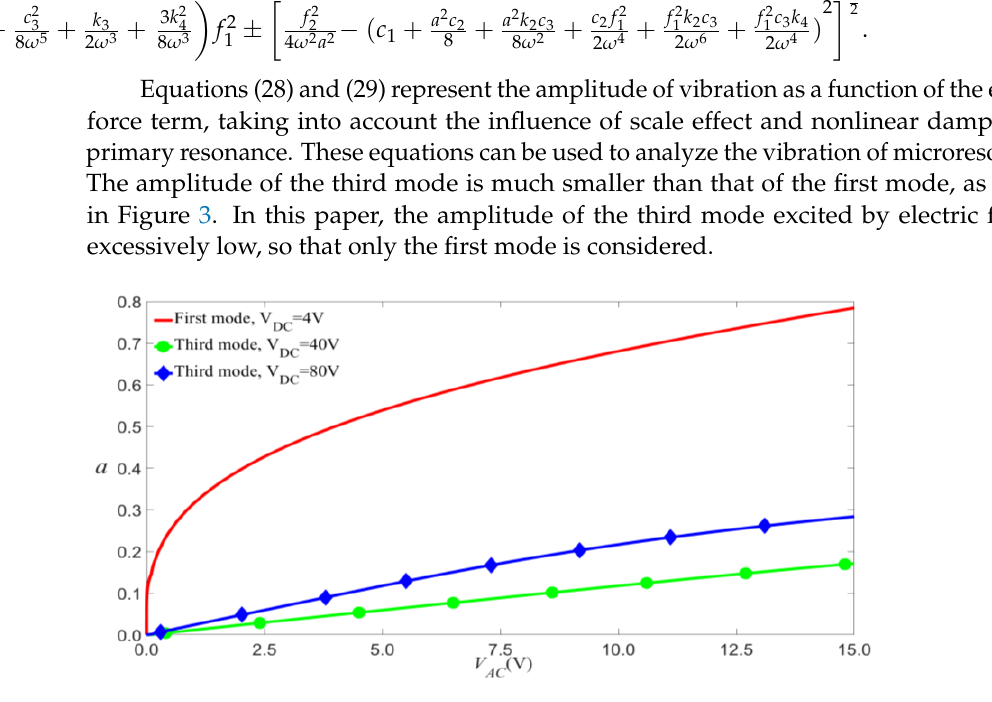
Figure 4. Time evolution of the midpoint displacement of microbeam under the context of primary resonance for